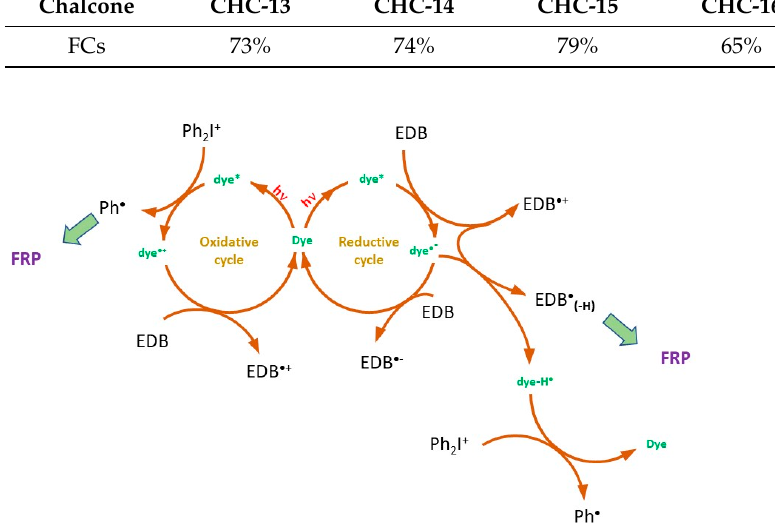
Table 4. Monomer conversions obtained during the FRP of PEGDA upon irradiation at 405 nm using the three-component Chalcone/Iod/EDB (1.5%/1.5%/1.5% w / w / w ) photoinitiating systems in thin films. Data extracted from Ref. [143].